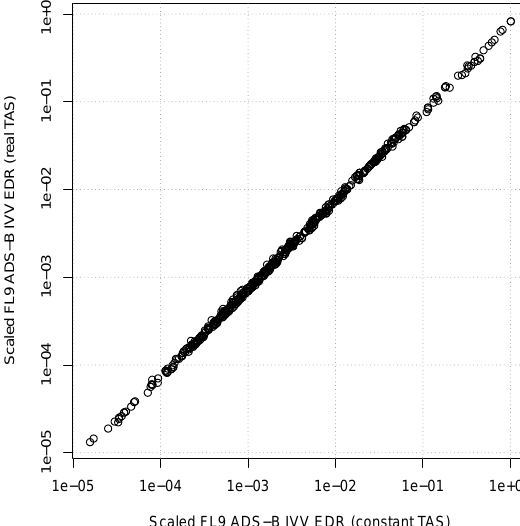
Figure 9. Comparison of the threshold crossing method results for | T C | = 0 . 4 for positive and negative threshold.